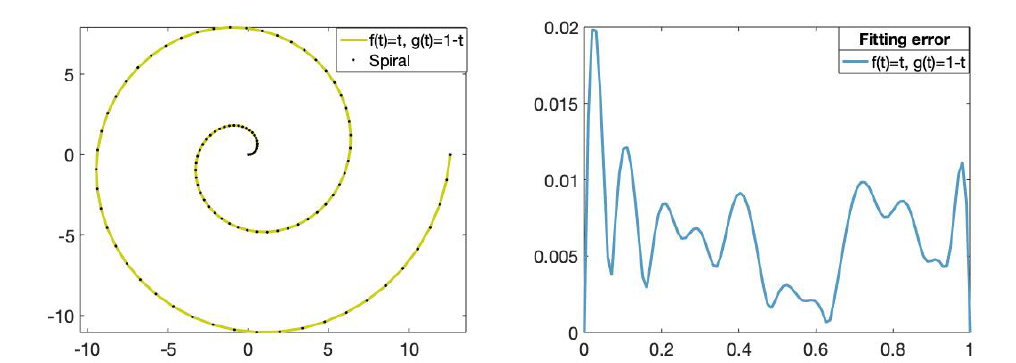
Figure 12. ( Left ): Set of data points on the Archimedean spiral (dotted) and the fitting curve of degree 11 obtained using the functions f ( t ) = t and g ( t ) = 1 − t , t ∈ [ 0,1 ] . ( Right ): The x -axis represents the parameters t in [ 0,1 ] and the y -axis represents the fitting error value of the fitting curve obtained using the functions f ( t ) = t and g ( t ) = 1 − t